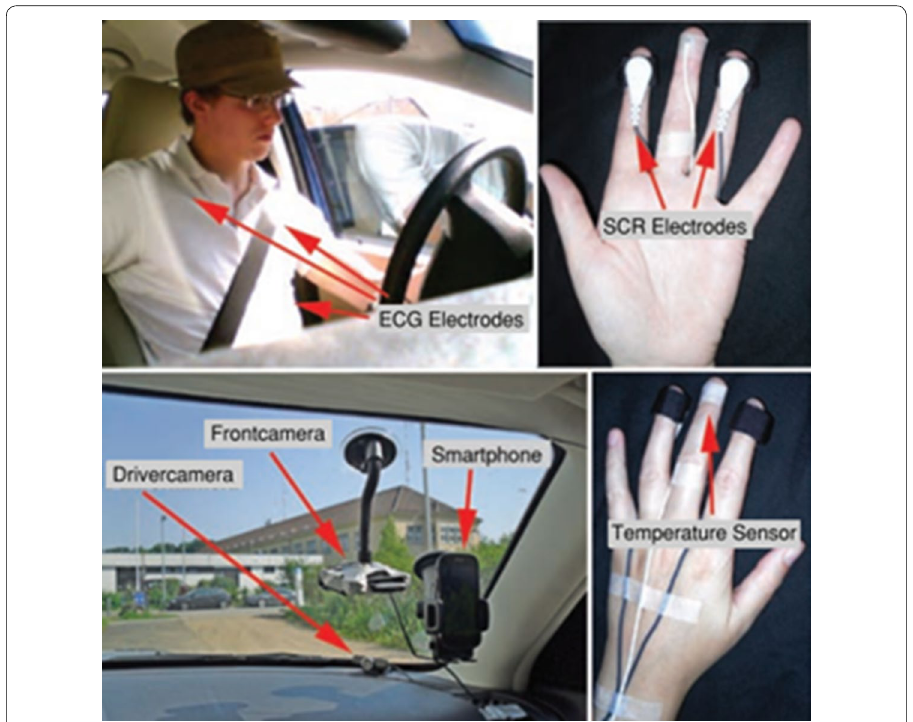
Fig. 3 HciLab study setup: two cameras and a smartphone are placed within the car (bottom left). The driver is connected to electrodes measuring the heart rate (top left). Skin conductance response (top right) and body temperature (bottom right) are measured at the drivers left hand